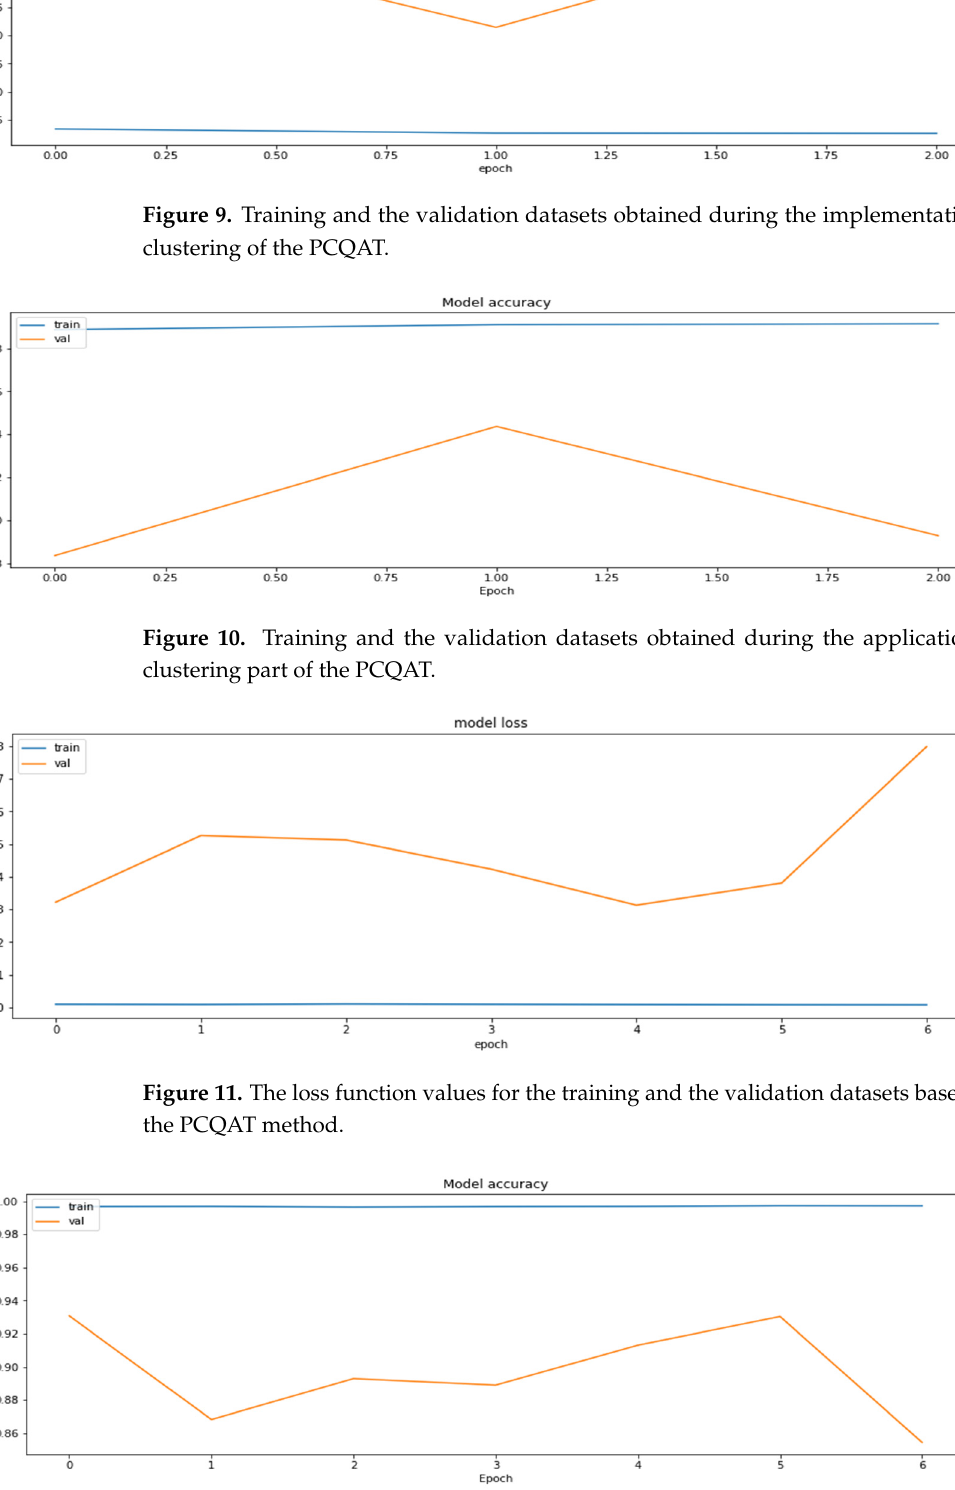
Figure 12. The accuracy of the model for the training and the validation datasets based on the QAT part of the PCQAT method.